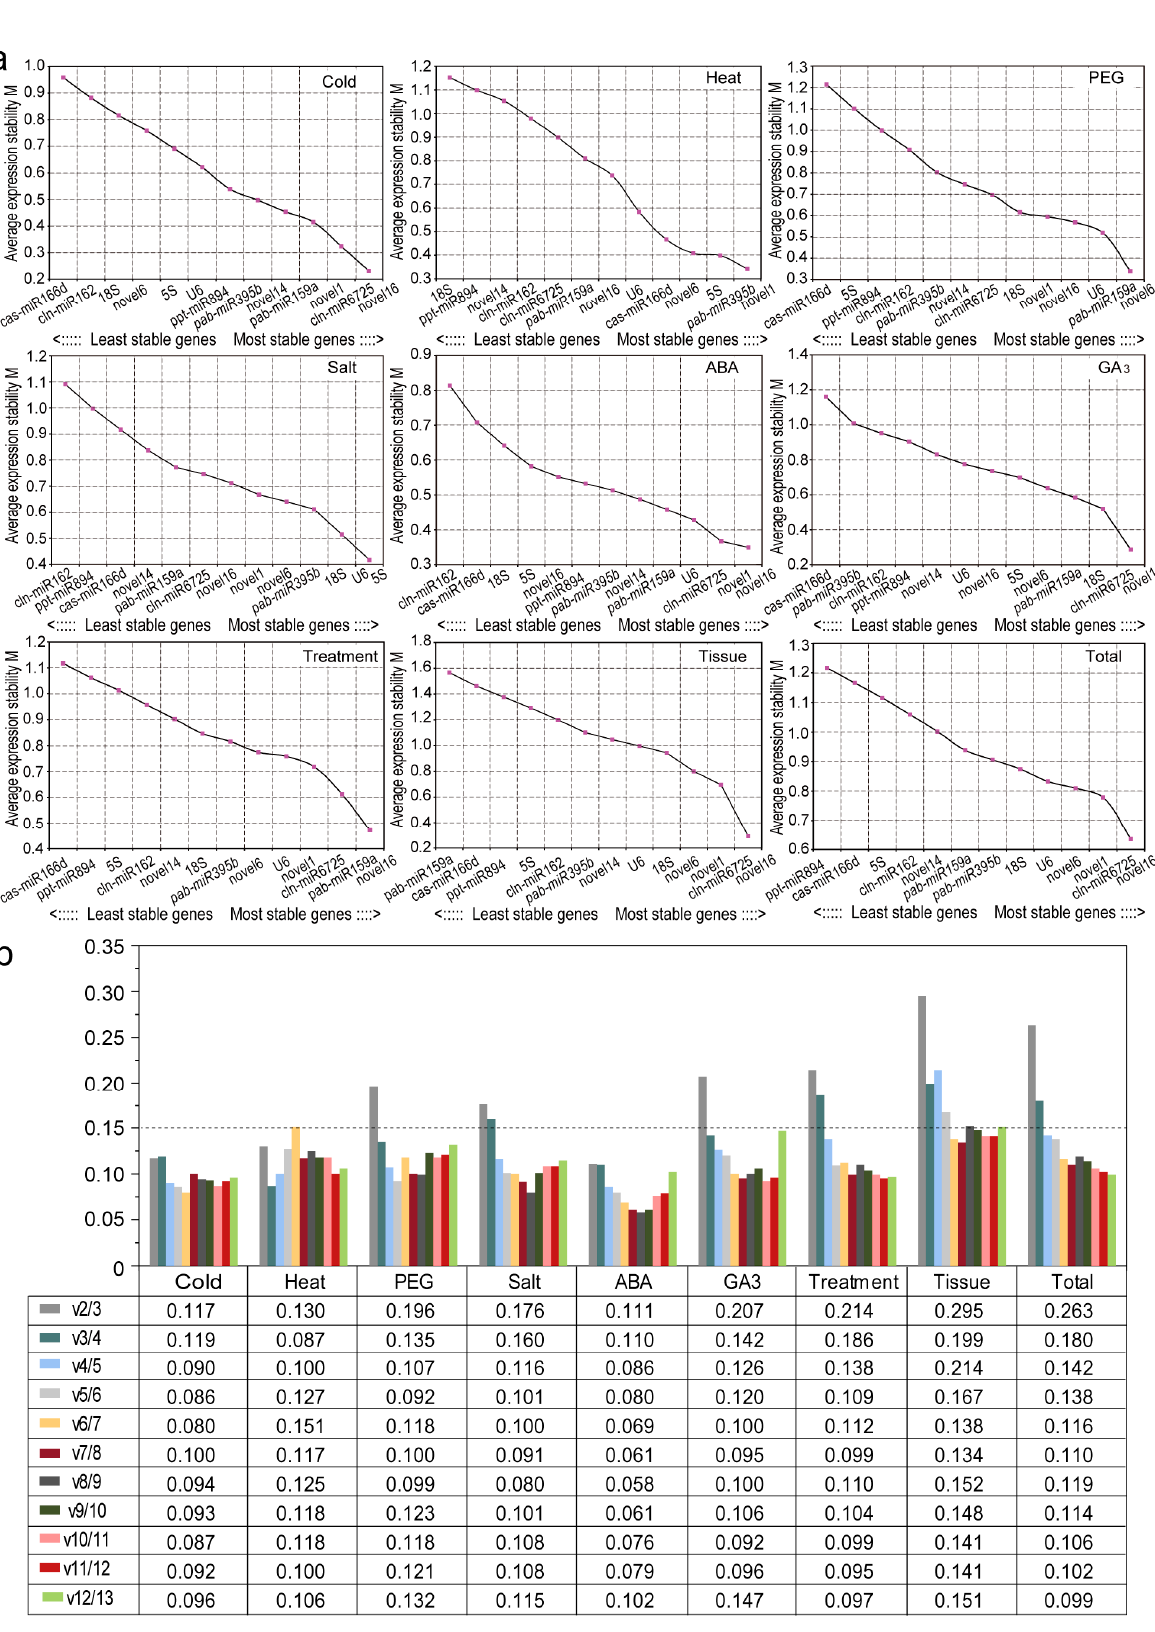
Figure 4. Average expression stability values and pairwise variations by geNorm analysis. ( a ) Expression-stability values (M) and rankings of the 13 candidate reference genes of C. fortunei calculated using geNorm. The most and least stable genes are on the right and left, respectively. ( b ) Determination of the optimal number of reference genes for C. fortunei .